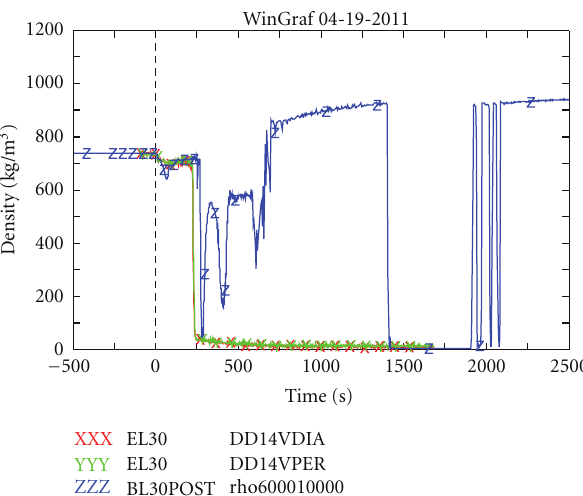
Figure 9: Intact loop seal (pump inlet)